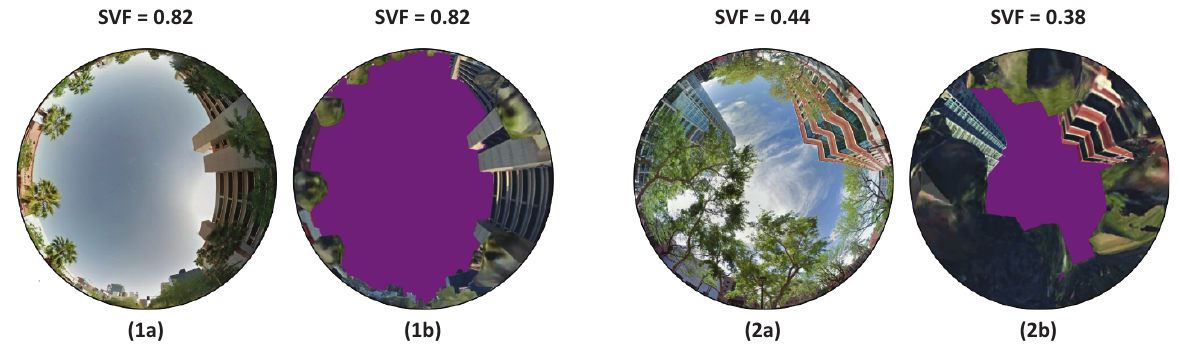
Figure 2. Comparison of fisheyes and Sky View Factors generated from Google Street View images (1a, 2a) and Google Earth 3D meshes (1b,